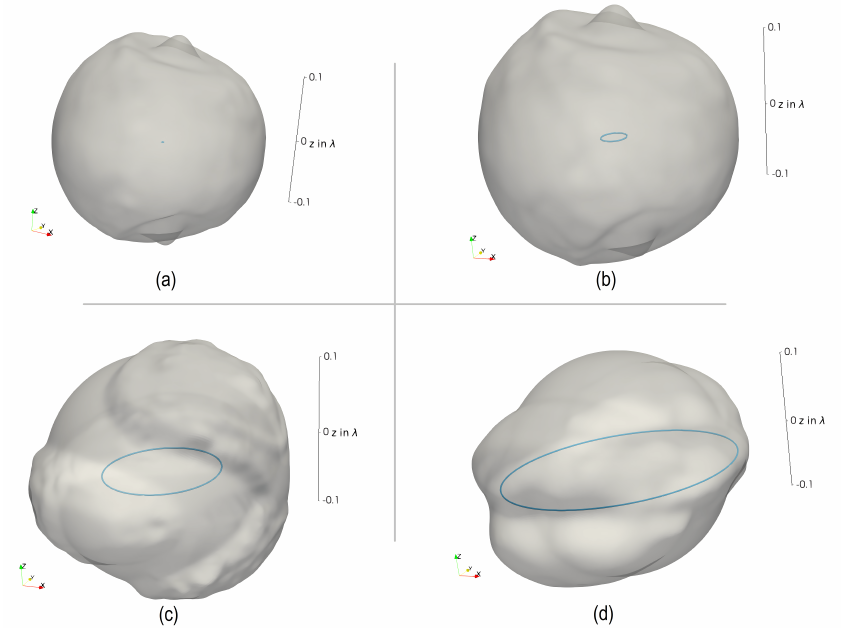
Figure 23. The reactive NF region, described by the angular-dependent radius r near ( θ , φ ) , when apply- ing the error estimator 11 with err NR 2 ( r near ( θ , φ ) , θ , φ ) = 1 of a loop antenna with the circumference of ( a ) C = 0.01 λ , ( b ) C = 0.1 λ , ( c ) C = 0.45 λ , and ( d ) C = 1 λ